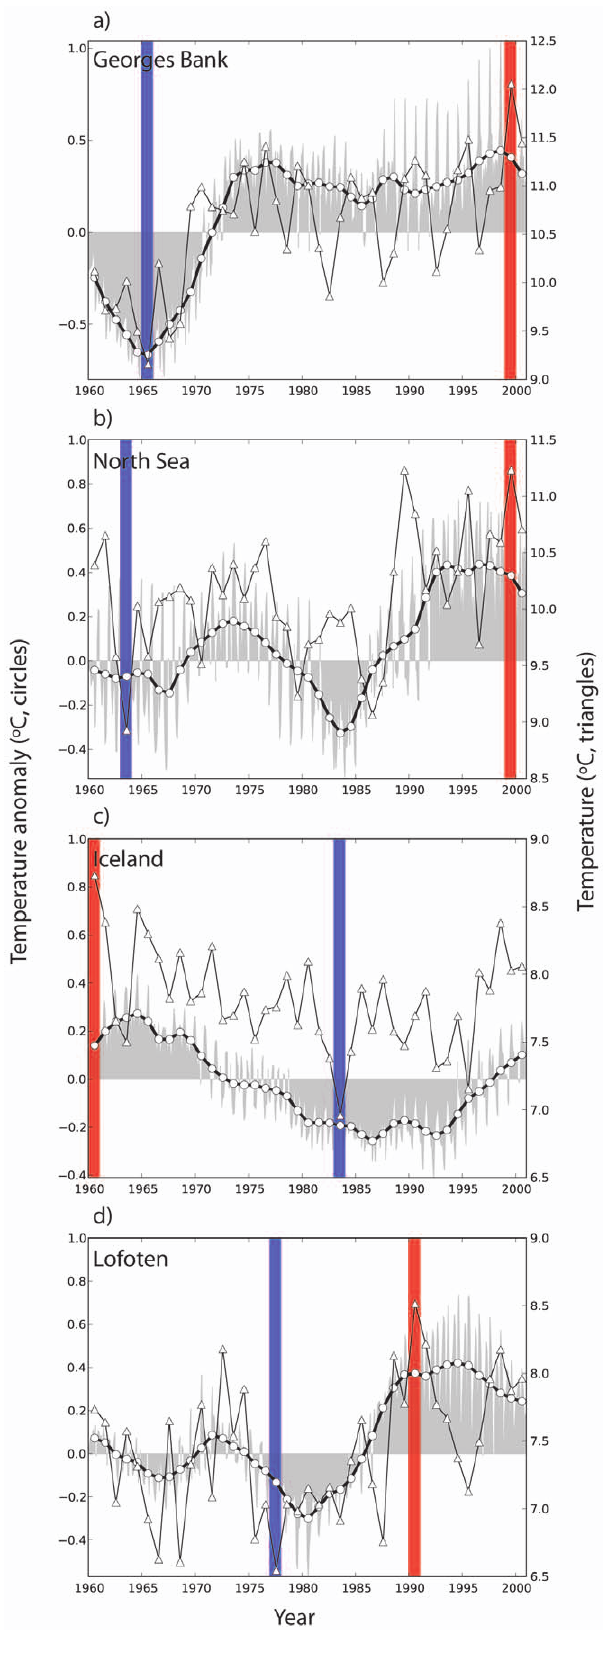
Figure 2. Time series of surface temperature reveal both colder (e.g. 1960’s) and warmer (e.g. 1990’s) time periods relative to the climatology (1961–1990). The red bar indicates the warmest year on average for the upper 50 meters (or to the deepest depth if shallower) while the blue bars indicate the coldest. Surface temperature anomalies ( u C left y-axis, black thick line with circles) were smoothed with a 9-year running mean, and plotted with the unsmoothed surface temperature anomalies ( u C, left y-axis, light grey), and surface temperature ( u C, right y-axis, dark grey lines with light triangles). All time series are shown from 1960 to 2002 for the four studied locations in the North